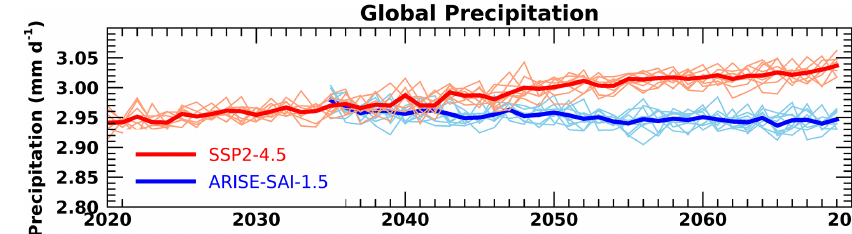
Figure 5. Same as Fig. 3a but for precipitation.